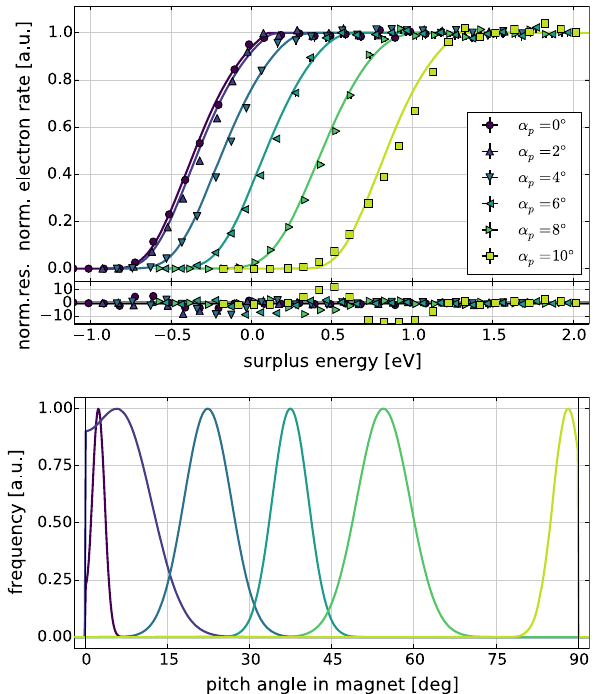
Fig. 9 Measured transmission functions and angular distributions at different plate angles α p with U ana = − 18 . 6kV and B + start = 27mT. The given residuals are in absolute units. As expected, a shift towards largersurplusenergiesisobservedforincreasingplateangles.Magnetic reflection occurs at α p ≈ 10 ◦ , leading to a significant deformation of the transmission function w.r.t. the reference measurement at α p = 0 ◦ .